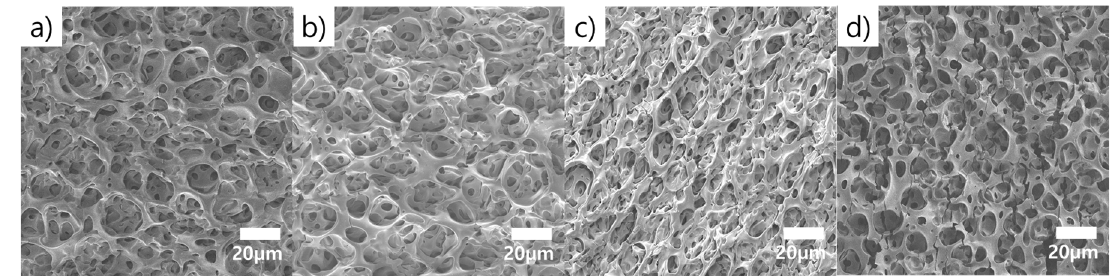
Figure 4. FE-SEM images showing metal (Ti/Au) deposited onto the porous PDMS surface during application of tensile strain with ( a ) 10%; ( b ) 20%; ( c ) 30%; and ( d ) 40% strain.